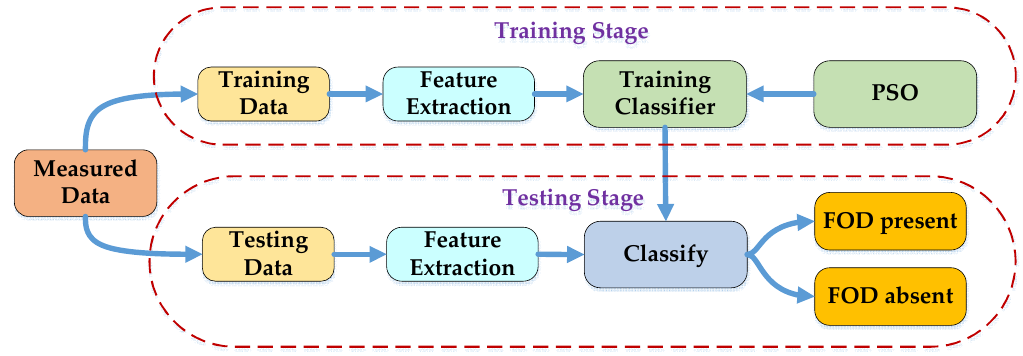
Figure 2. Flowchart of the FOD classification. PSO: Particle Swarm Optimization.